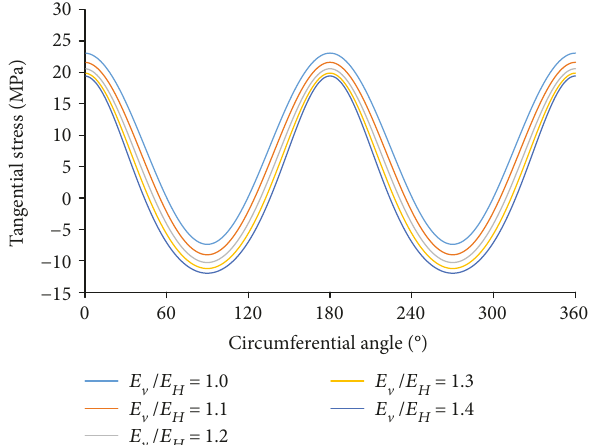
Figure 8: The relationship curves between tangential stress and circumferential angle of di ff erent E v / E H .